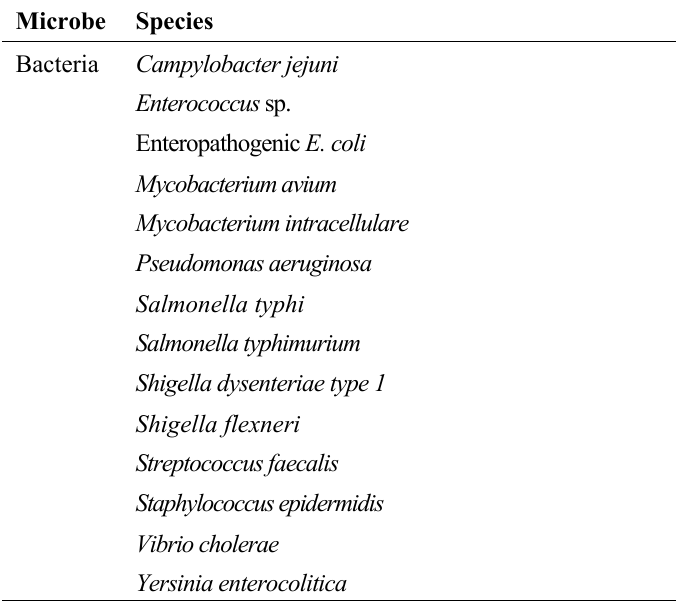
Table 3. Waterborne microbial species known to be inactivated by solar disinfection